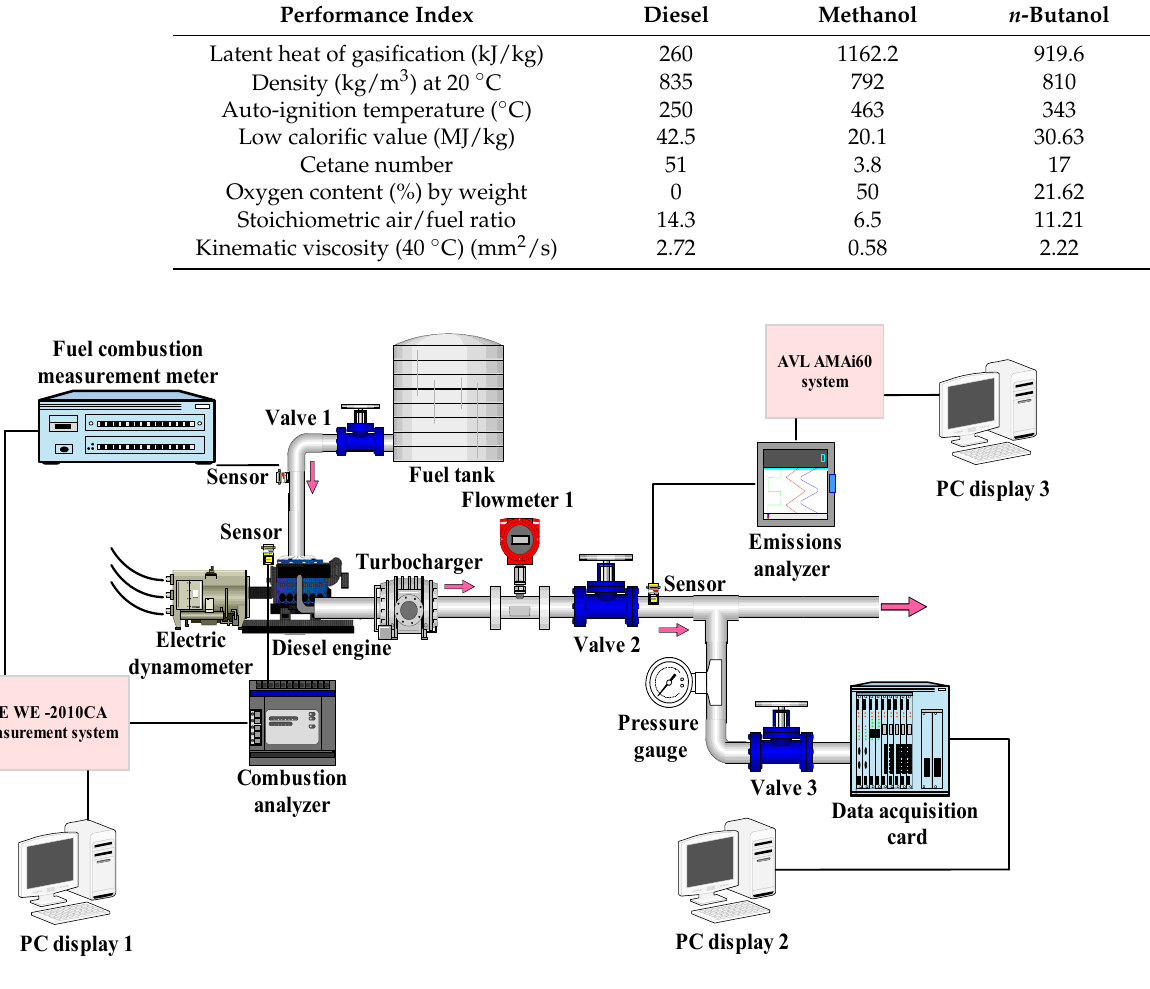
Figure 3. Schematic diagram of engine test. Table 3. Specifications of the main measuring instruments.